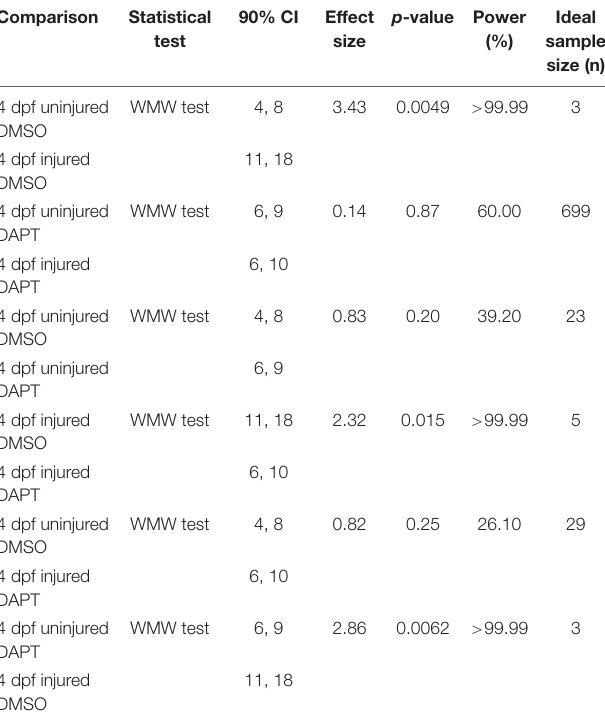
TABLE 5 | Calculation of statistical power for comparing the number of muSCs after muscle injury in 8 dpf zebrafish larvae in the presence of DAPT.